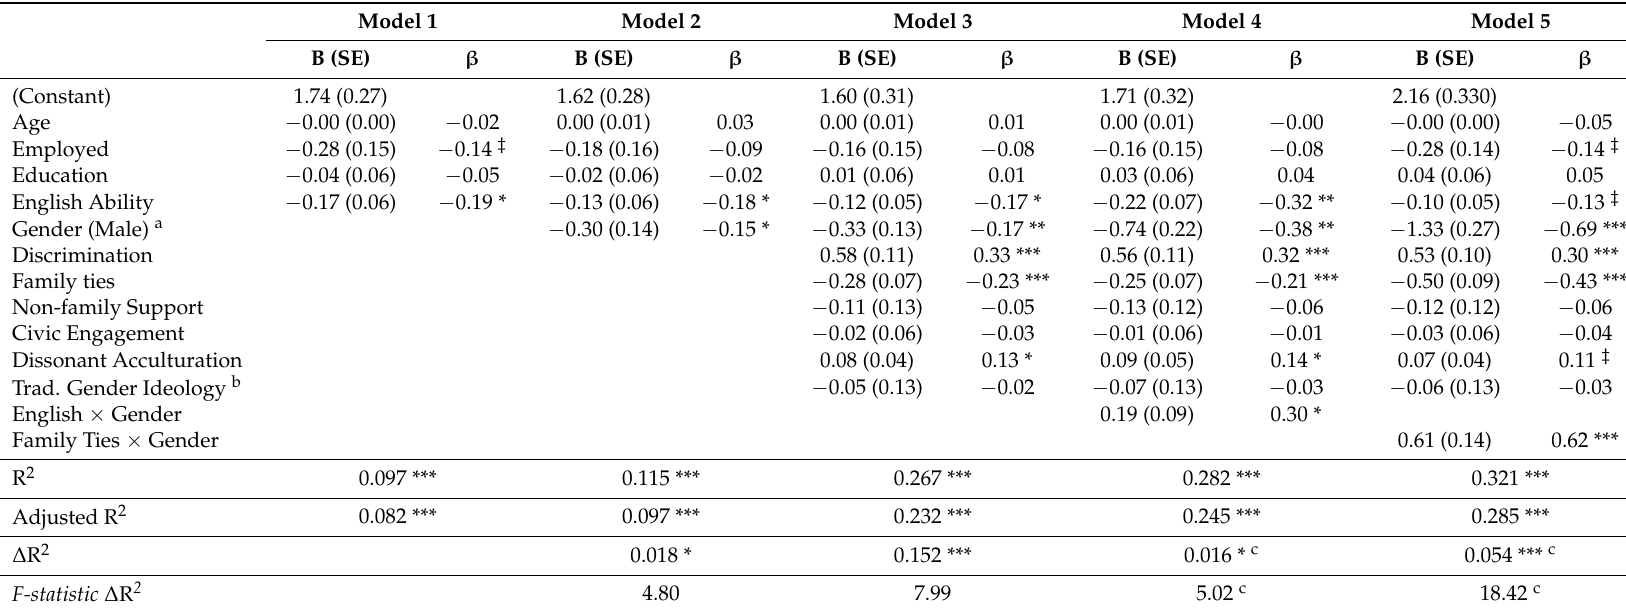
Table 2. Resettlement factors and factors moderated by gender explaining psychological distress